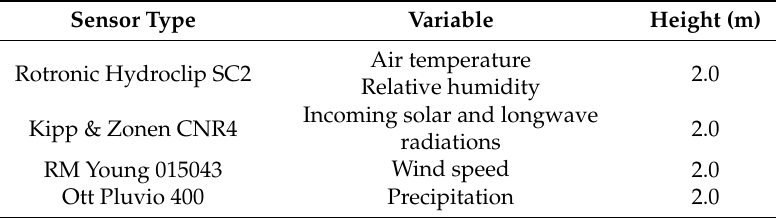
Table 1. Variables measured and sensors used in the Campbell AWS and pluvio installed at Yala Glacier base camp located at 5060 m